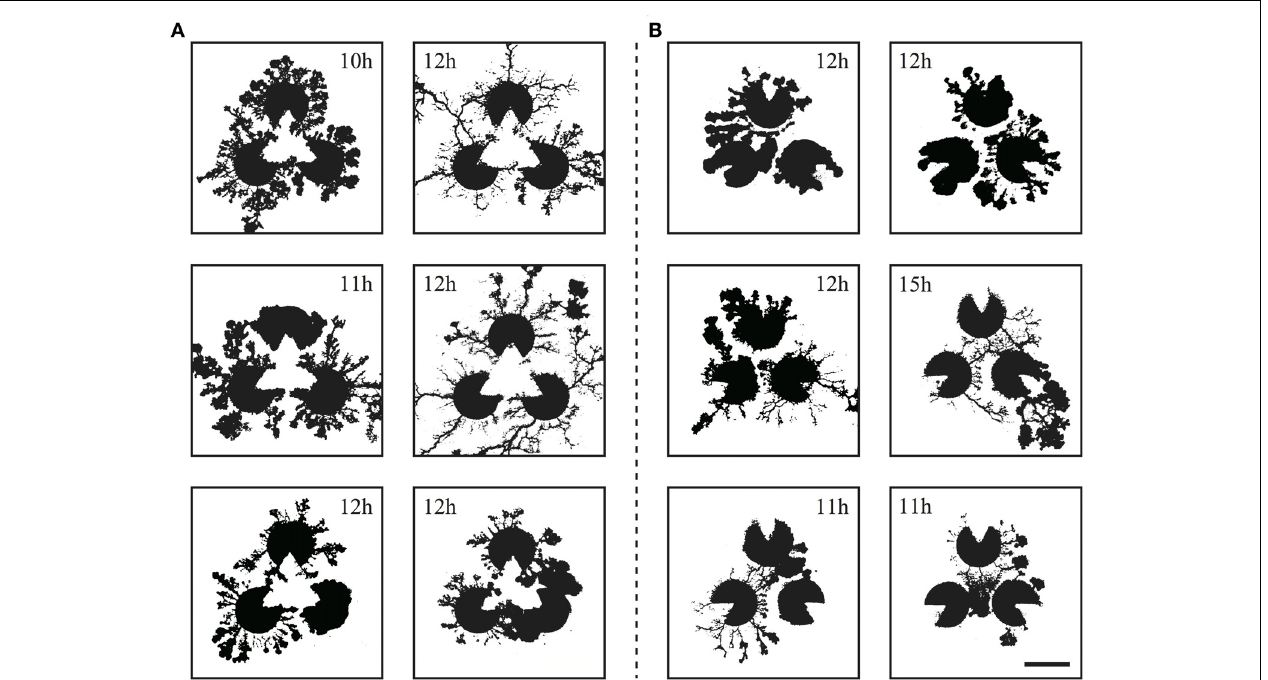
FIGURE 8 | The resulting networks from the real Physarum experiment (scale bar: 10mm) corresponding to the Kanizsa diagram (A) and the control (B). The time stamp of each